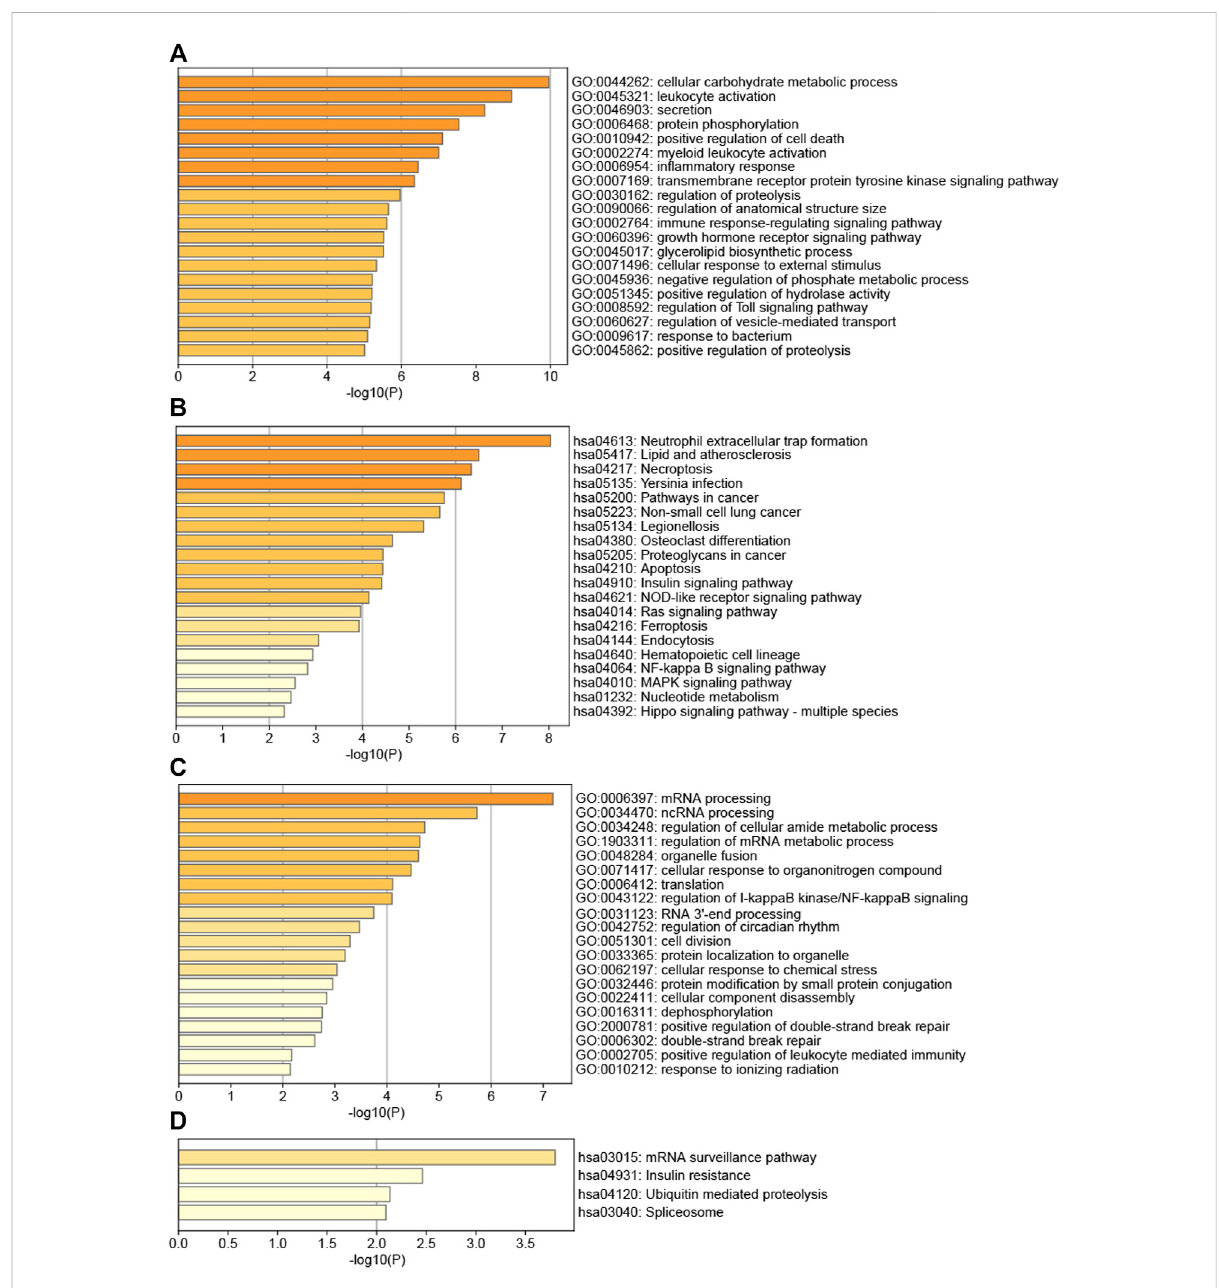
control of acute in fl ammatory response comprising the majority (Figure 10A). To further investigate the speci fi c mechanism of key I-DEGs, the key I-DEGs were imported into the KEGG database, and we identi fi ed 24 pathways comprising at least two genes after fi ltering. (Figure 10B). Interestingly, TNF and IFNAR1